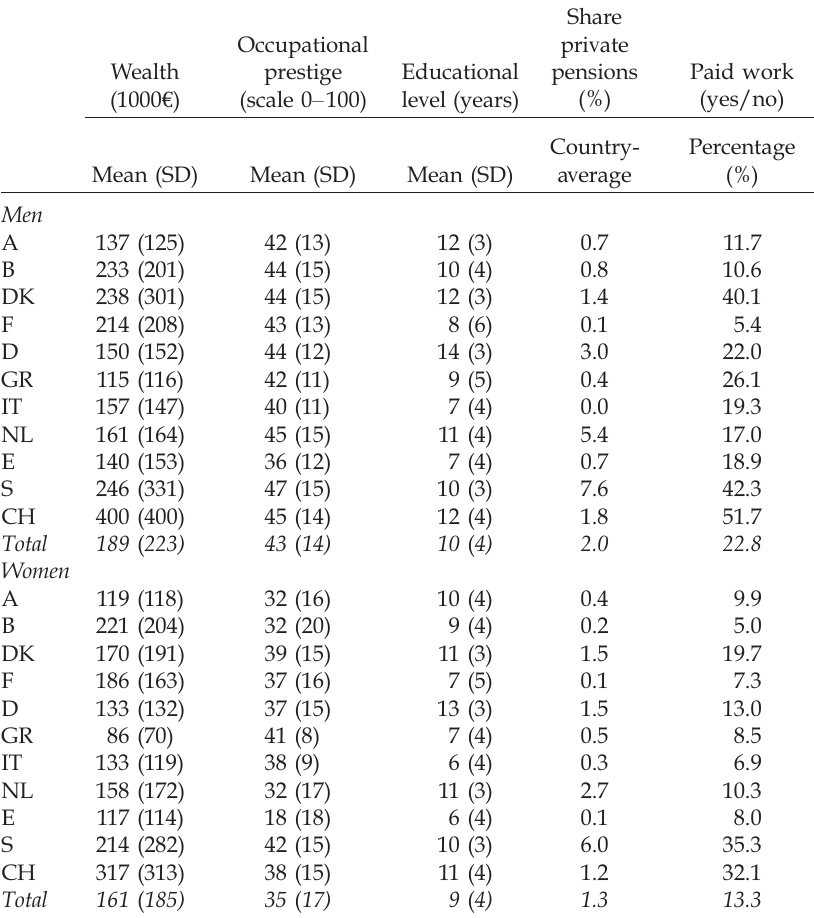
Table 1. Sample descripti v e statistics for explanatory and explained v ariables, per gender and